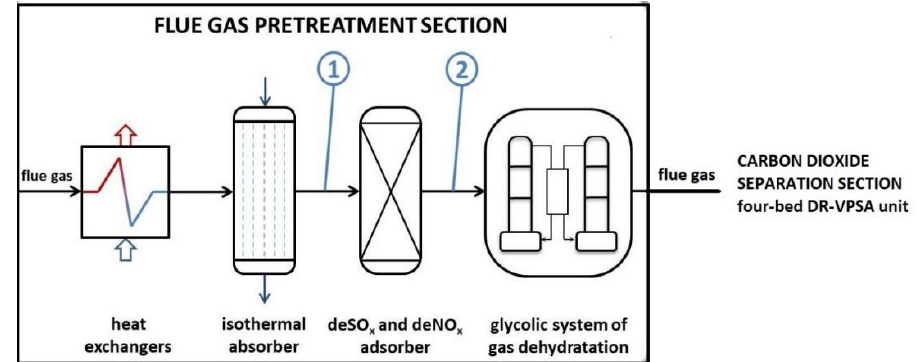
Figure 2. The scheme of the pilot DR-VPSA unit including the locations of the AC sample retrieval for analysis purposes (1, 2: flue gas drawing locations). for analysis purposes (1, 2: flue gas drawing